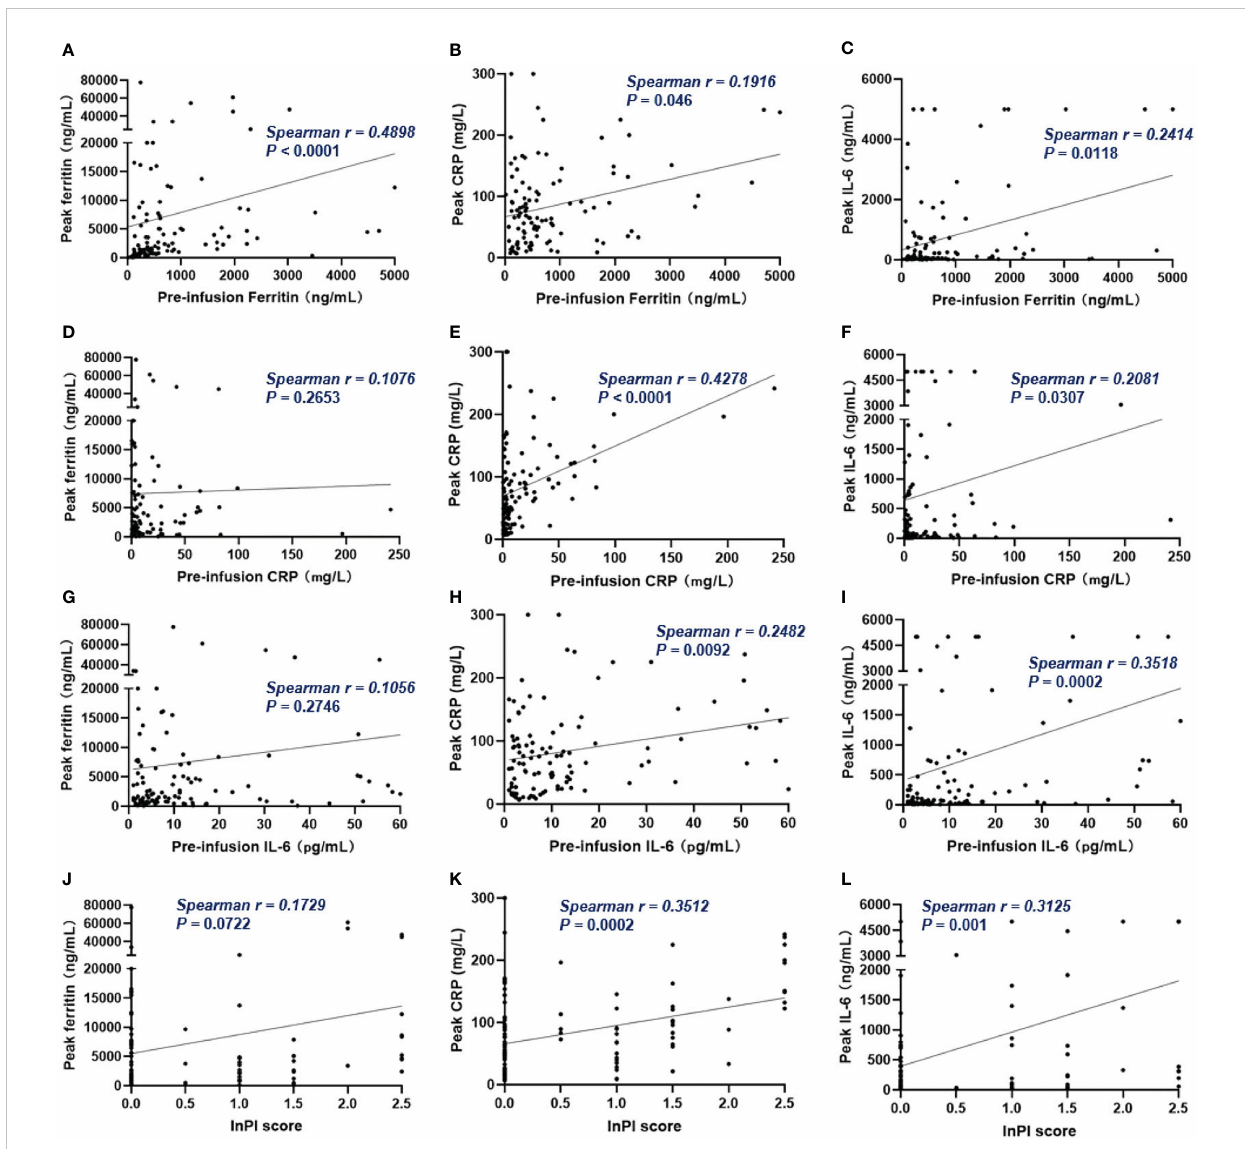
FIGURE 5 The correlation between pre-infusion in fl ammatory markers, InPI score and the post-infusion peak in fl ammatory markers. (A – C) Pre-infusion levels of ferritin correlated with the peak values of ferritin, CRP and IL-6. (D, G) Pre-infusion CRP and IL-6 had no correlation with peak ferritin. (E, F) Pre- infusion CRP correlated with peak CRP and IL-6. (H, I) Pre-infusion IL-6 correlated with peak CRP and IL-6. (J – L) InPI score positively correlated with peak ferritin, CRP, and IL-6. Spearman r value was calculated using the Spearman ’ s correlation